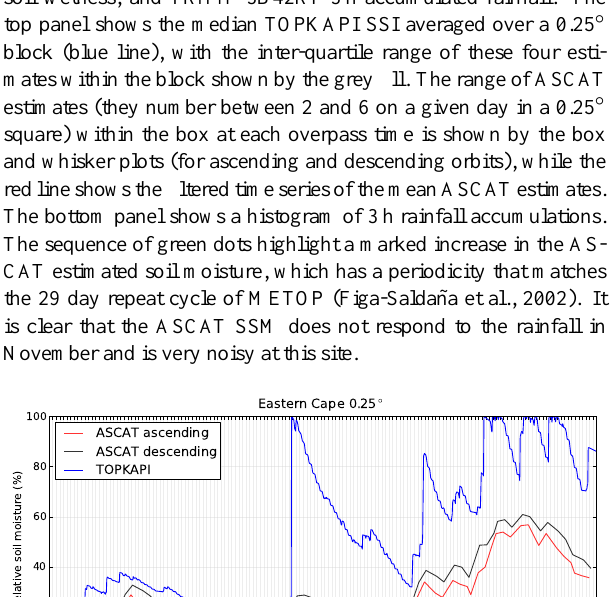
Fig. 14. Site C – Liebenbergsvlei. The description of this figure is the same as Fig. 13, except that a 0.5 ◦ block has been used.